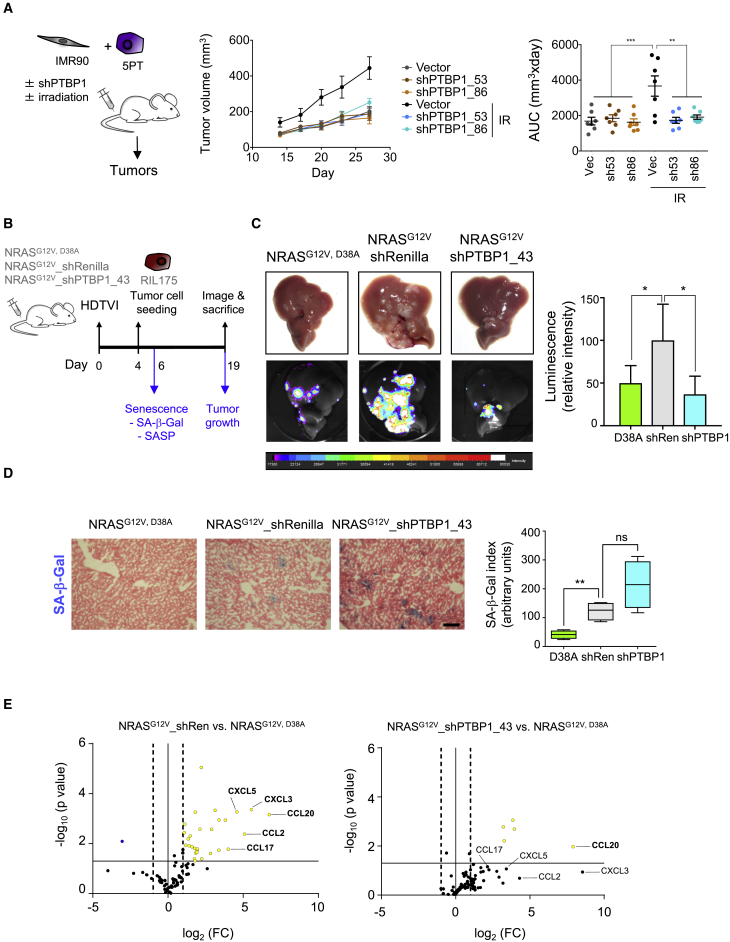
PTBP1 Knockdown Inhibits the Tumor-Promoting Functions of the SASP(A) Tumor growth induced by senescent cells in a xenograft mouse model following PTBP1 knockdown. Left: experimental design. Middle: tumor growth monitored by measuring the volume at the indicated days. Graph symbols are mean volumes of all the mice in the indicated condition. Right: area under the curve (AUC) of the tumor growth for each mice. Data represent mean ± SD (n = 7 per group). ∗∗p < 0.01, ∗∗∗p < 0.001, one-way ANOVA (Bonferroni’s test).(B–E) Tumor growth in an orthotopic model of advanced liver cancer following PTBP1 knockdown. (B) Experimental design. (C) Representative images of livers and luciferase imaging (left) and quantification of luciferase intensity (right) shown as mean ± SD (n = 4 mice per group). ∗p < 0.05, one-way ANOVA (Bonferroni’s test). (D) Representative images and quantification of SA-β-Galactosidase expression. Scale bar: 50 μm. Plots show median (line), upper and lower quartiles (boxes), and lines extending to highest and lowest observation (whiskers), ∗∗p < 0.01; ns, not significant; one-way ANOVA (Bonferroni’s test). (E) qRT-PCR-based quantification of SASP components shown as log2 (FC) between the conditions indicated at the top.See also Figure S5.